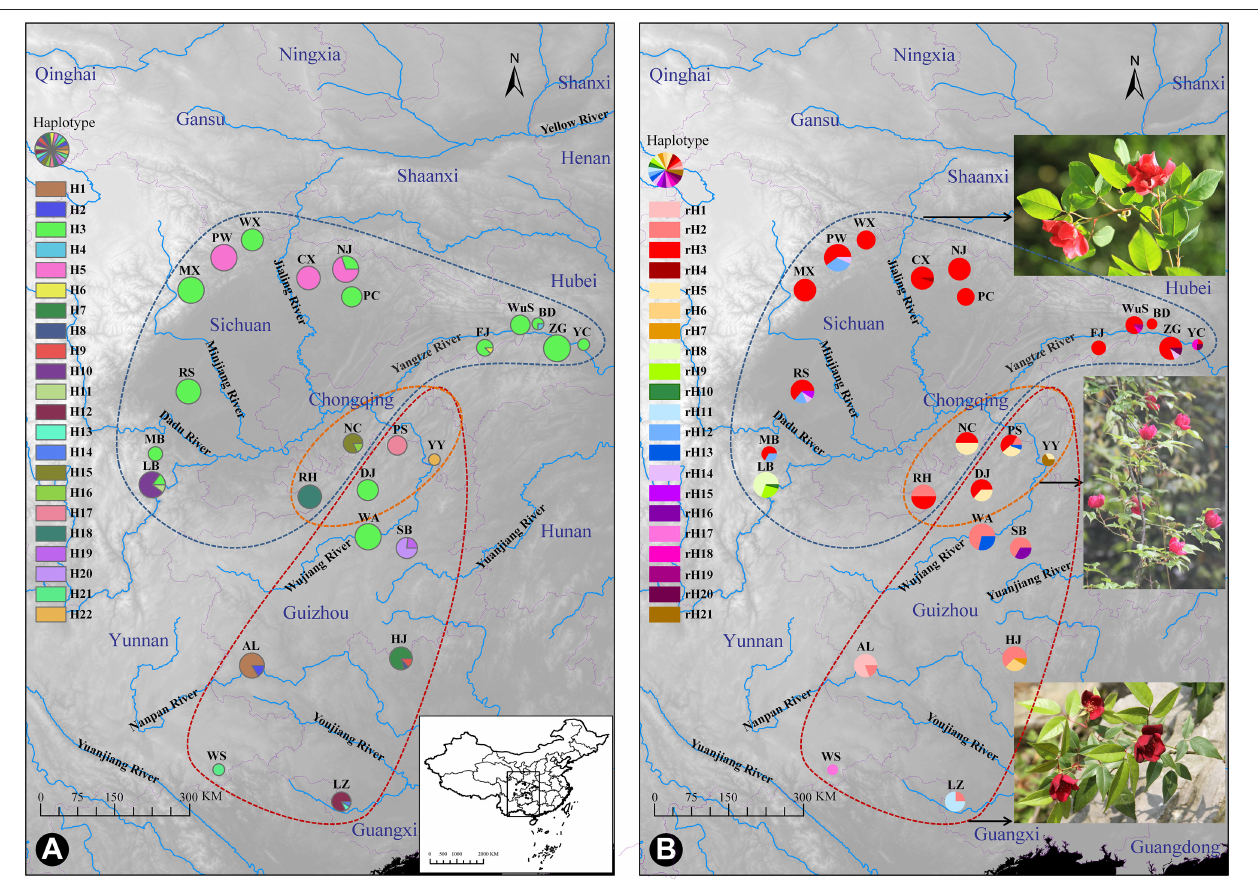
FIGURE 1 | Distribution of cpDNA haplotypes (A) and ITS ribotypes (B) of Rosa chinensis var. spontanea (area encircled by the blue curve) and R. lucidissima (area encircled by the red curve). Pie charts show the frequency of haplotypes/ribotypes in each population. The approximate location of the complex’s distribution was shown in (A) . The orange curve shows the transitional zones of the two taxa. The photos of each taxa and the plant in the transitional zones were shown close to their geographical distribution, respectively, in (B)